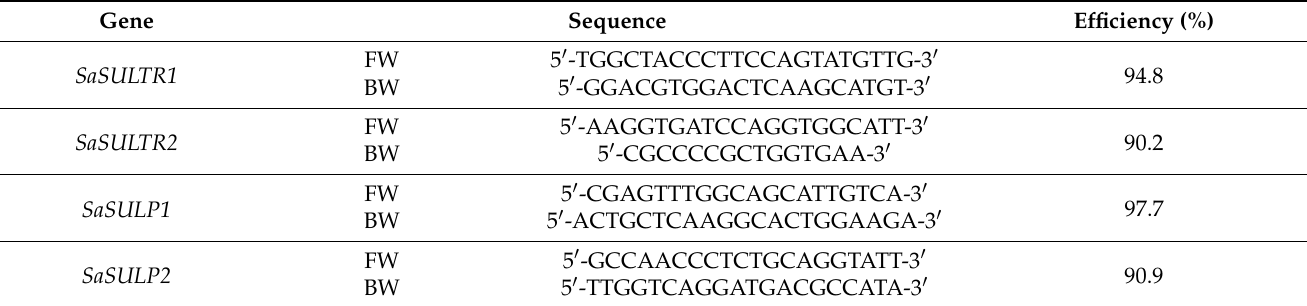
Table 2. List of primers used for aqPCR of studied genes encoding sulfur transporters.